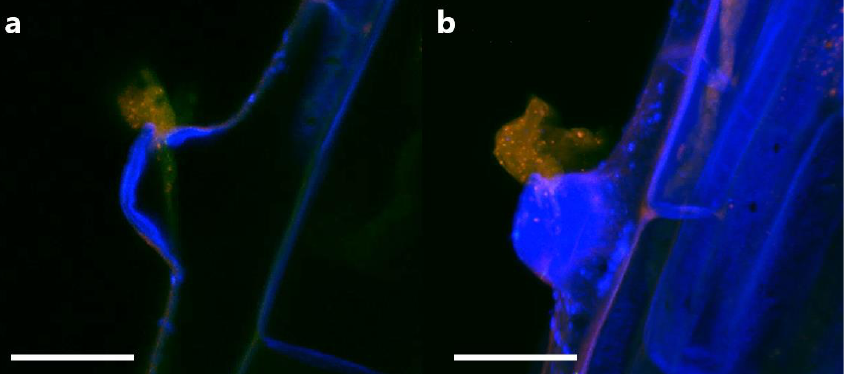
Figure 14. P3AW:mCherry are expelled at the root hair tips. ( a ) A 2D image of intact P3AW: mCherry cells, along with free-floating mCherry and DNA, escaping a root hair primordial. ( b ) The same scene is rendered as a 3D confocal stack. Scale bar = 15 μm.